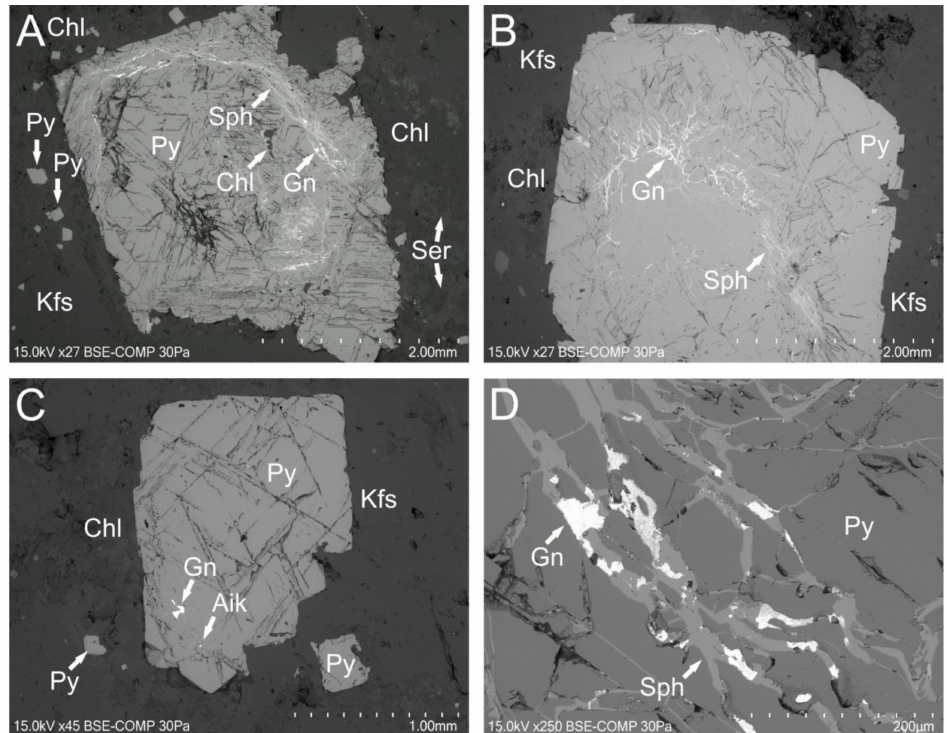
Figure 9. SEM back-scattered images of Py-IV (polymetallic quartz stage). ( A , B , D ) Cataclastic texture of Py-IV. Veinlets filled with galena and sphalerite, ( C ) Inclusion of aikinite-group mineral. Abbreviations: Py—pyrite, Chl—chlorite,